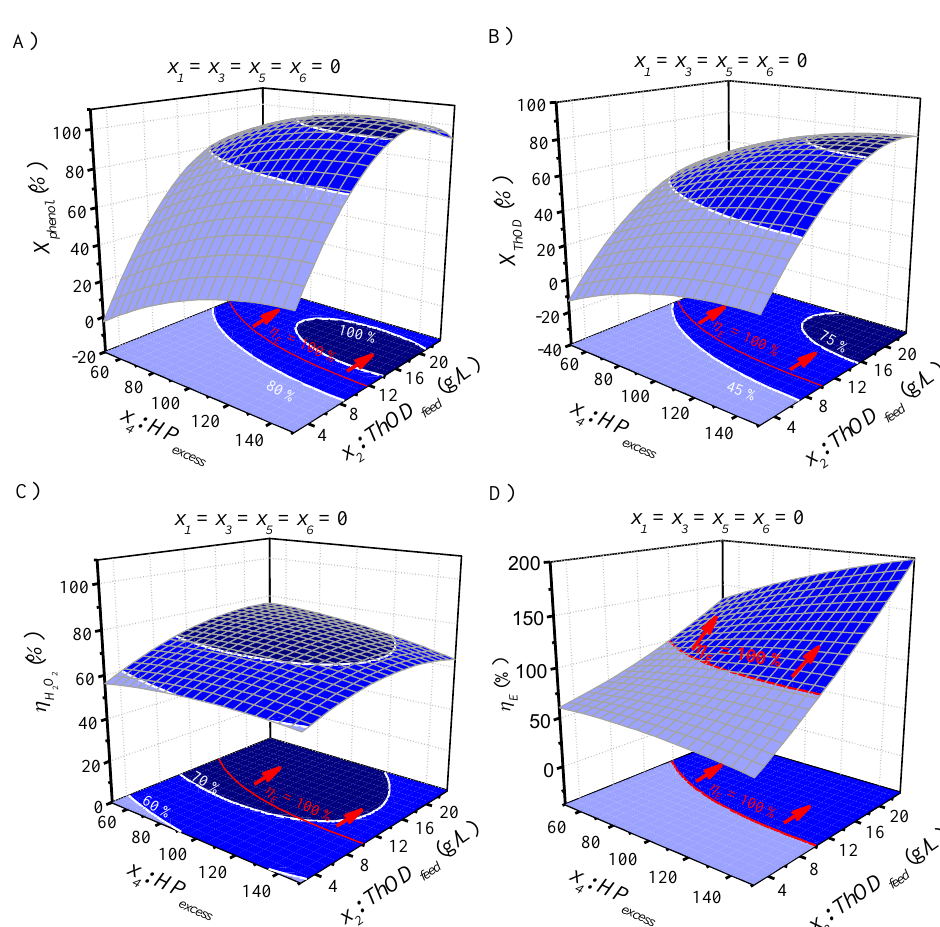
Figure 5. Response surfaces, contour plots and surface projections for X phenol ( A ), X ThOD ( B ), η H2O2 ( C ) and η E ( D ) as predicted by the quadratic models at di ff erent HP excess and ThOD feed values under T output = 90 ◦ C (x 1 = 0), T output = 45 ◦ C (x 3 = 0), τ = 165 g · h · mol − 1 (x 5 = 0) and T input = 20 ◦ C (x 6 = 0).